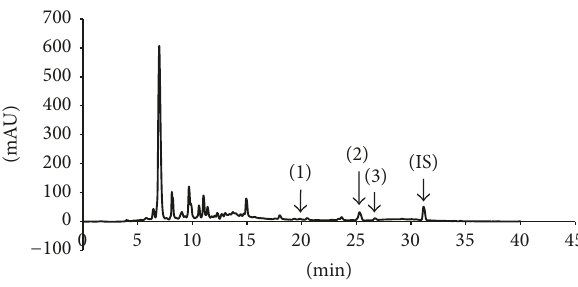
Figure 1: Representative HPLC chromatogram of a proso millet extract ( (1) syringic acid; (2) 𝑝 -coumaric acid; (3) ferulic acid) and the internal standard (IS), methyl paraben.